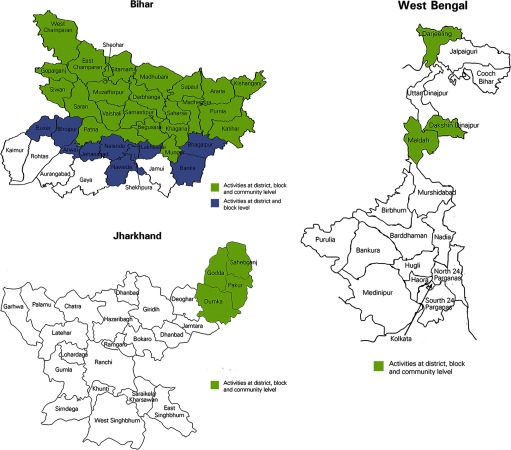
Location of Project Districts in Bihar, Jharkhand, and West Bengal States of India, February 2016 to March 2017